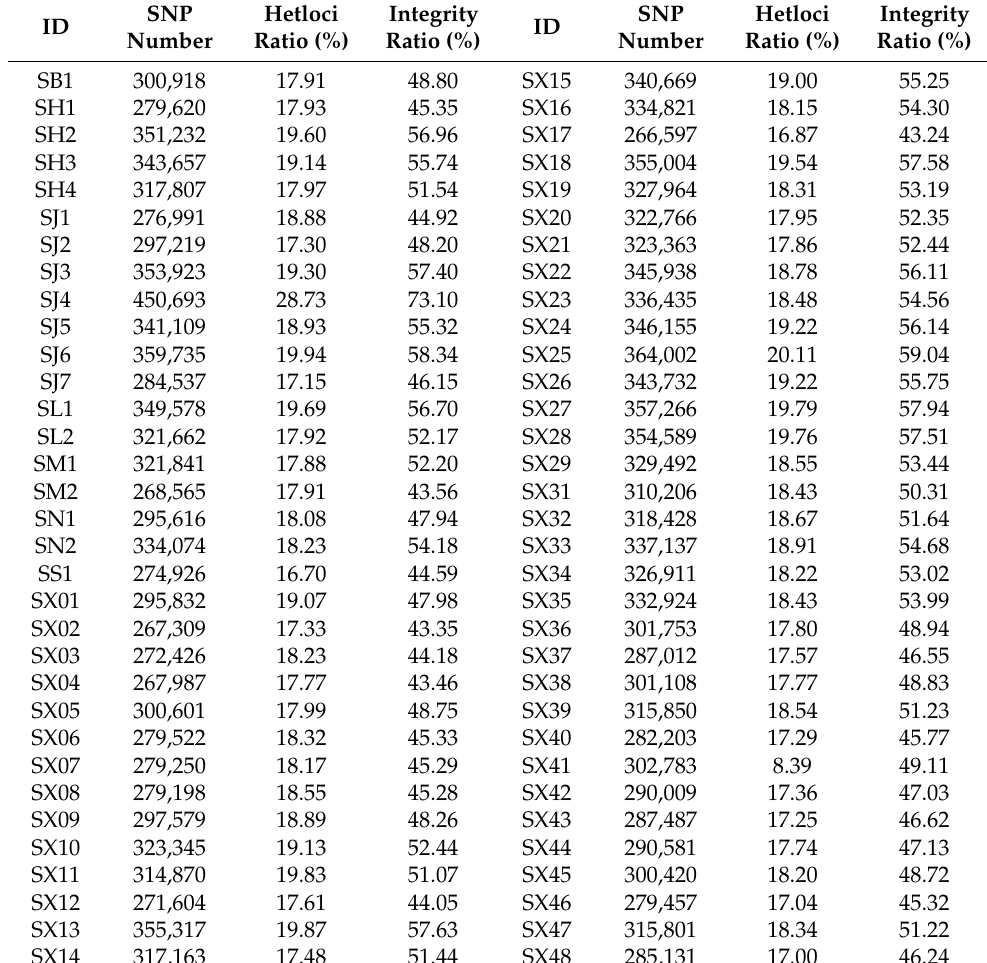
Table 4. Summary statistics for SNP sequence